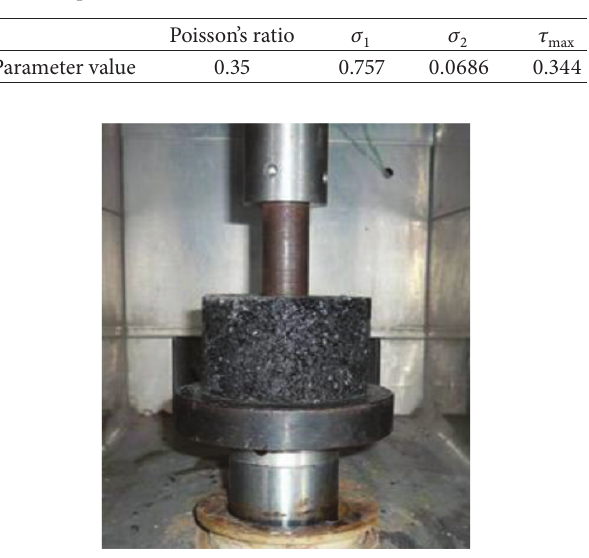
Figure 7: Penetration shear test